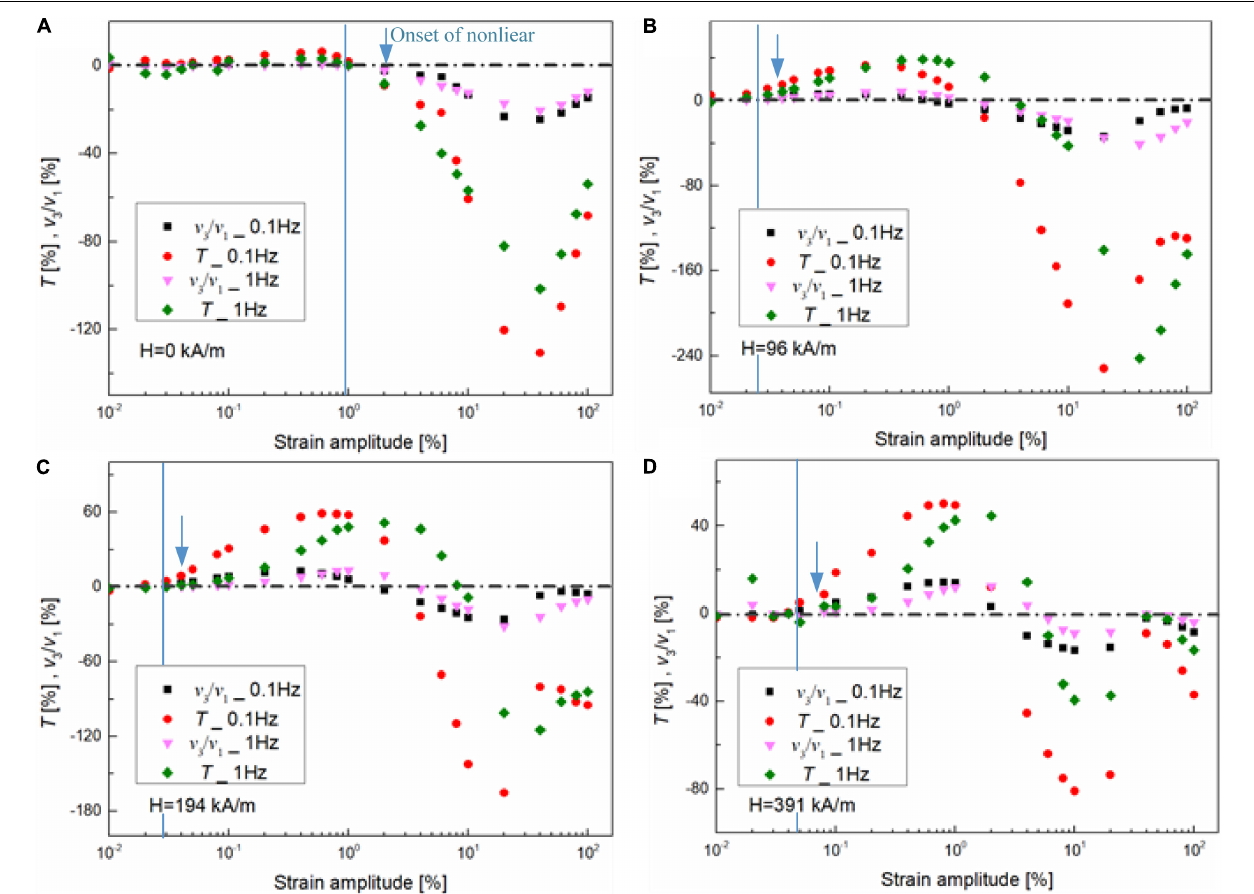
FIGURE 10 | Strain dependence of viscous Chebyshev coefficients ratios, i.e., v 3 / v 1 , and shear-thickening ratio, T , for MRG-70 under different oscillatory frequency, i.e., 0.1 and 1 Hz. The LAOS test was conducted on four different magnetic fields, such as (A) 0, (B) 96, (C) 194, and (D) 391 kA/m. The dashed lines indicate the value of zero. The blue solid line is the boundary between linear and non-linear viscoelastic regimes. The blue arrow indicates the appearance of